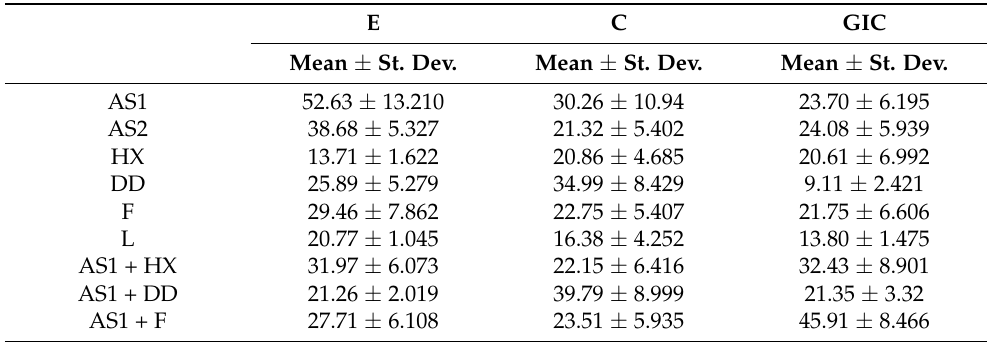
Figure 5. Contact angles between investigated liquids and enamel (E), glass-ionomer (GIC), and composite material (C). Table 1. Mean values and standard deviation of the contact angles between investigated liquids and enamel, glass-ionomer and composite